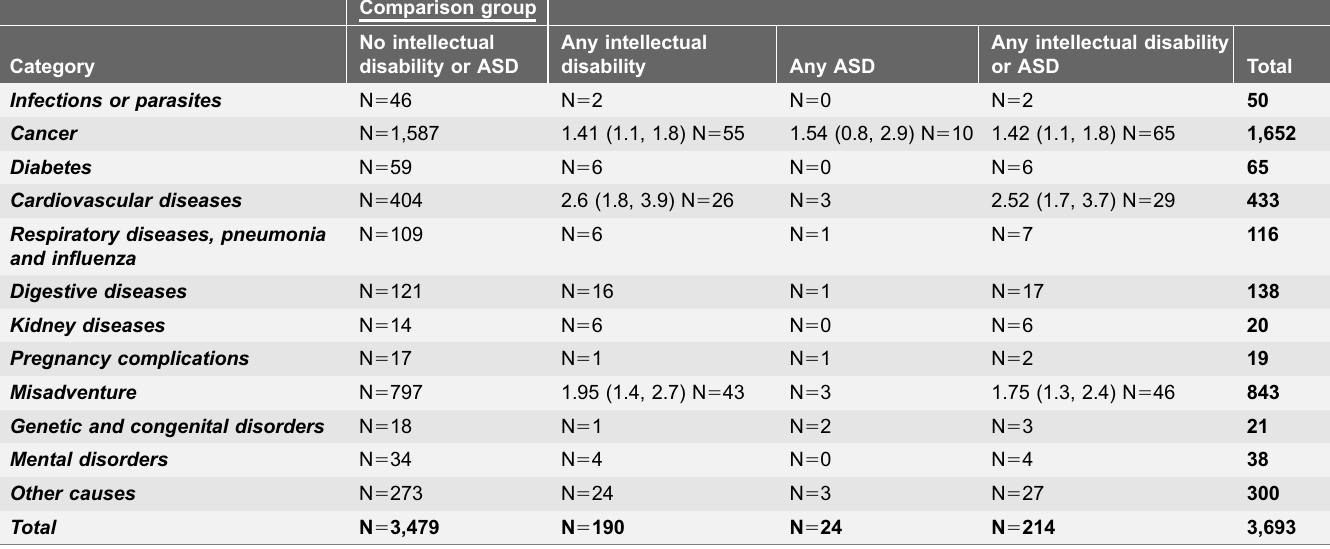
Table 2. Mothers experiencing death by case group and cause with hazard ratios and 95% confidence intervals for primary causes of death. Comparison